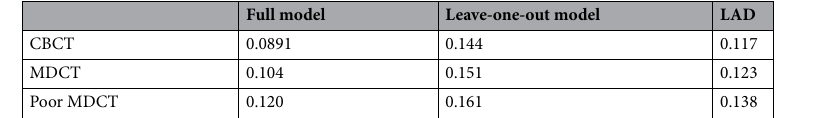
reported absolute errors for organ of Corti cochlear duct length of 1.69 ± 1.13mm : our comparable values at